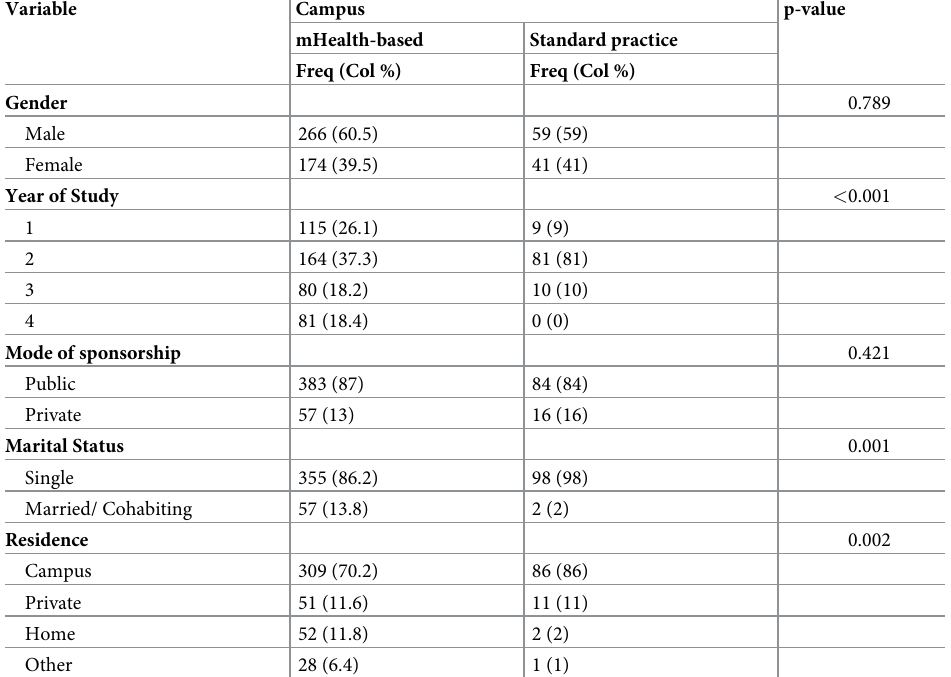
Table 2. Socio-demographic characteristics of the